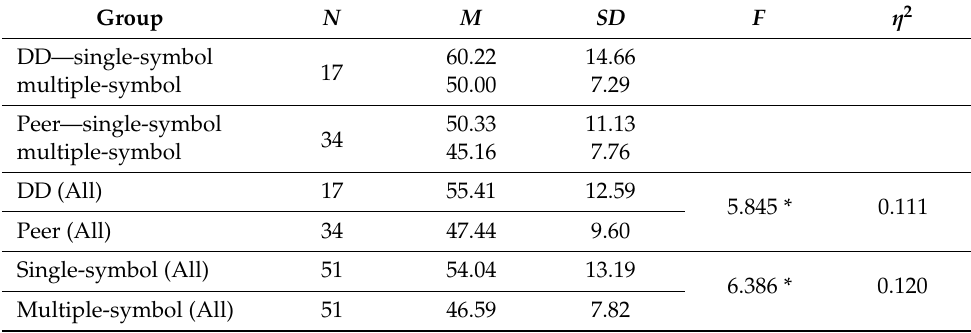
Table 5. Attention Index of children with and without developmental delays (DD) during PCS